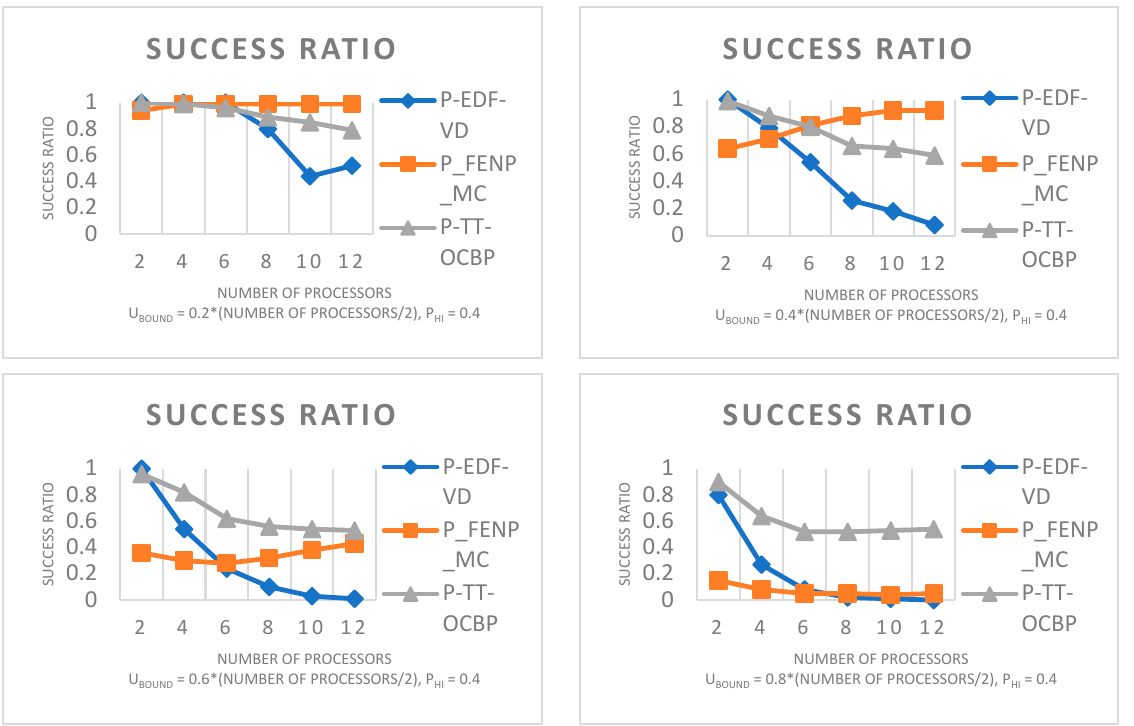
Figure 3. Success ratio by varying the utilization bound. U L = 0.05, U U = 0.75, Z L = 1, Z U = 4. For Figure 4, the number of processors on the x-axis ranges from 2 to 12, in steps of 2. It must be noted that between the four graphs, the Base Utilization bound (𝑈 × (𝑛𝑢𝑚𝑏𝑒𝑟 𝑜𝑓 𝑝𝑟𝑜𝑐𝑒𝑠𝑠𝑜𝑟𝑠/2)), ranges from 0.2 to 0.8, in steps of 0.2. The num- 𝐵𝑈 (cid:3029)(cid:3042)(cid:3048)(cid:3041)(cid:3031) ber of tasks in a task set varies according to the task set utilization bound. Therefore, a lower value on the x-axis decreases the number of tasks in a task set, while a higher value increases it.